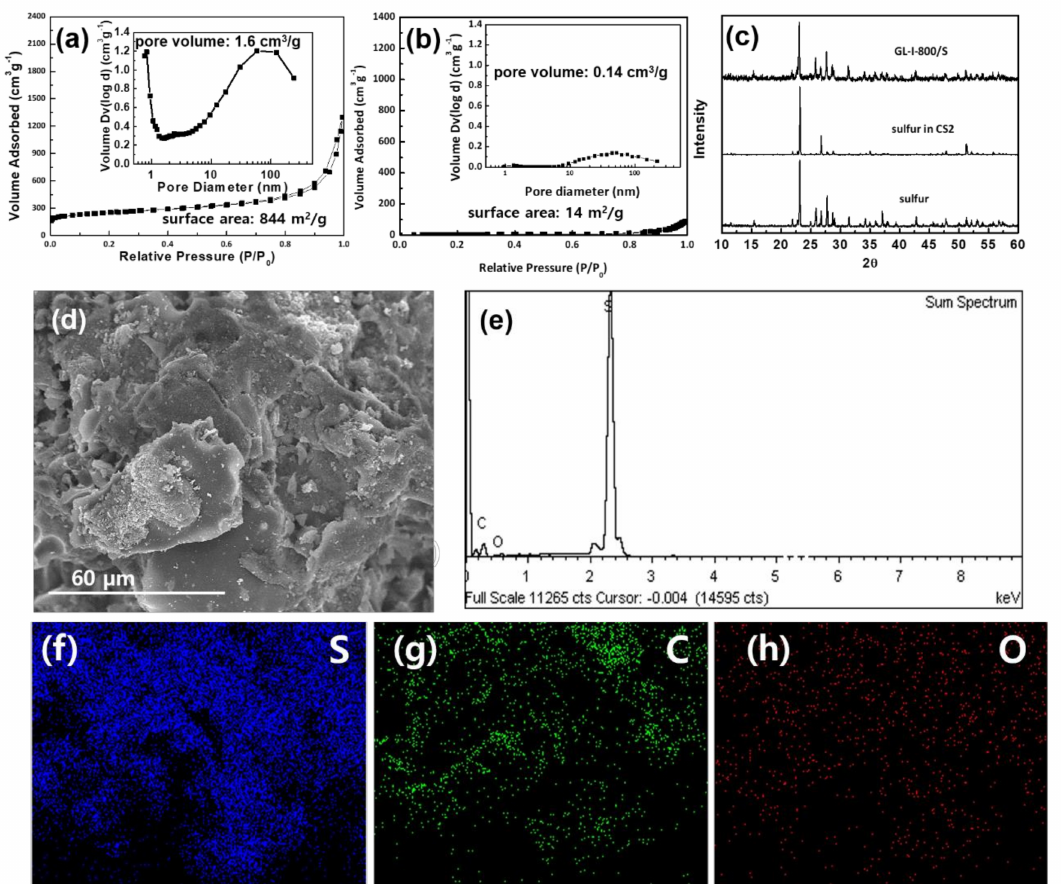
Figure 3. N 2 adsorption–desorption isotherm of ( a ) GL-I-800 and ( b ) GL-I-800 + S (inset images are pore size distribution). ( c ) XRD patterns of sulfur, sulfur recovered from CS 2 solution, and sulfur infiltrated GL-I-800. ( d ) SEM image of GL-I-800 + S. ( e ) Energy-dispersive spectroscopy (EDS) spectra of GL-I-800 + S. EDS mapping of GL-I-800 + S: ( f ) sulfur; ( g ) carbon; ( h )